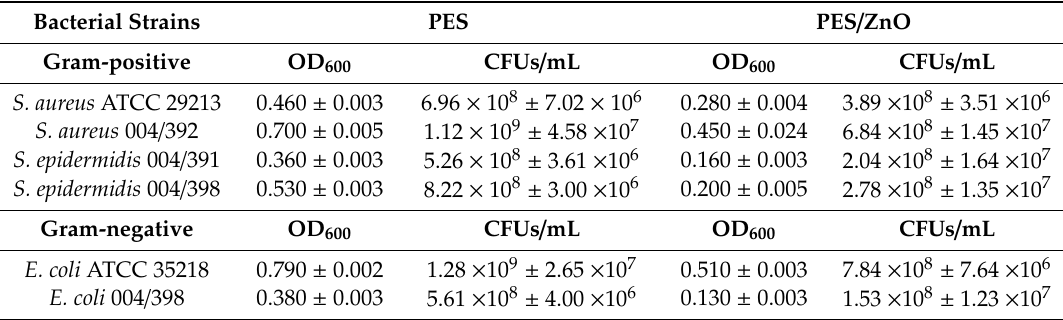
Table 4. Optical density (OD600) values and total bacterial count (CFUs / mL) obtained for PES and PES / ZnO fibers inoculated with di ff erent bacterial strains. Results are expressed as mean of three experiments ± standard